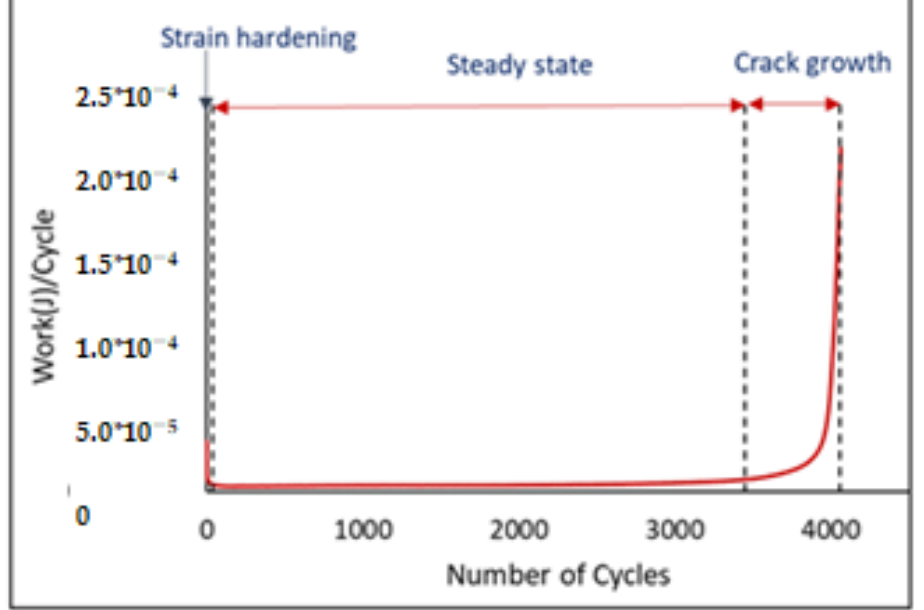
Figure 6. Stress-strain curve at 16 MPa stress level and 25 °C operating temperature.